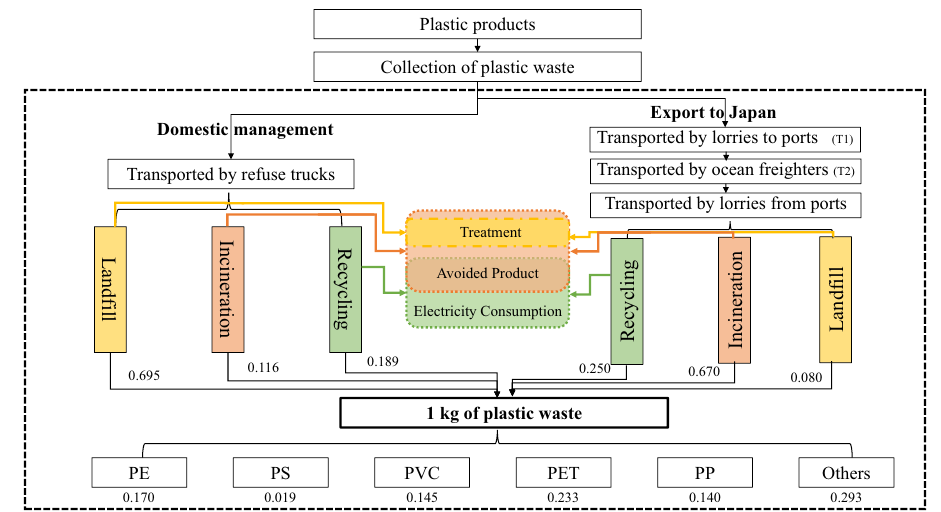
Fig. 3 System boundaries for LCA of EIT. Here, China ’ s export to Japan under the Baseline Scenario is taken as an example. The dotted line is the system boundary. The proportion of different types of plastic waste generated in China is shown at the bottom of the Figure. For example, PE accounts for 0.170 kg of 1 kg of plastic waste. For every 1 kg of plastic waste (generated by China) treated domestically, the environmental impact of transportation by refuse trucks are considered together with the environmental impact from the three treatment options of China. Whereas, when exporting to Japan, both the environmental impact of sea and land transportation are considered fi rst, then that from plastic waste treatment options in Japan.